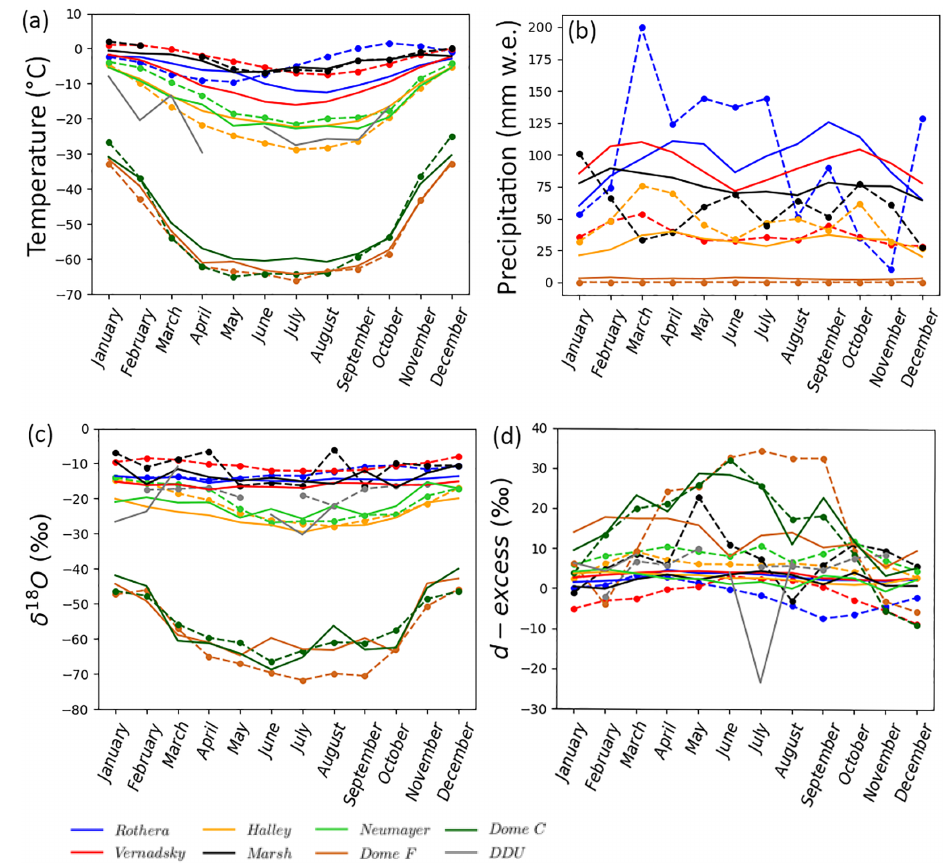
Figure 8. Average seasonal cycles from precipitation data over the available period (dashed lines with points) and simulated by the ECHAM5-wiso model over the period 1979–2013 (solid lines) of the temperature (in ◦ C) (a) , the precipitation (inmmw.e.yr − 1 ), the pre- cipitation δ 18 O (in ‰) (c) and the deuterium excess (in ‰) (d) . Data are shown for different durations depending on sampling, while model results are shown for the period 1979–2013. The number of points used for the observations is given in Table